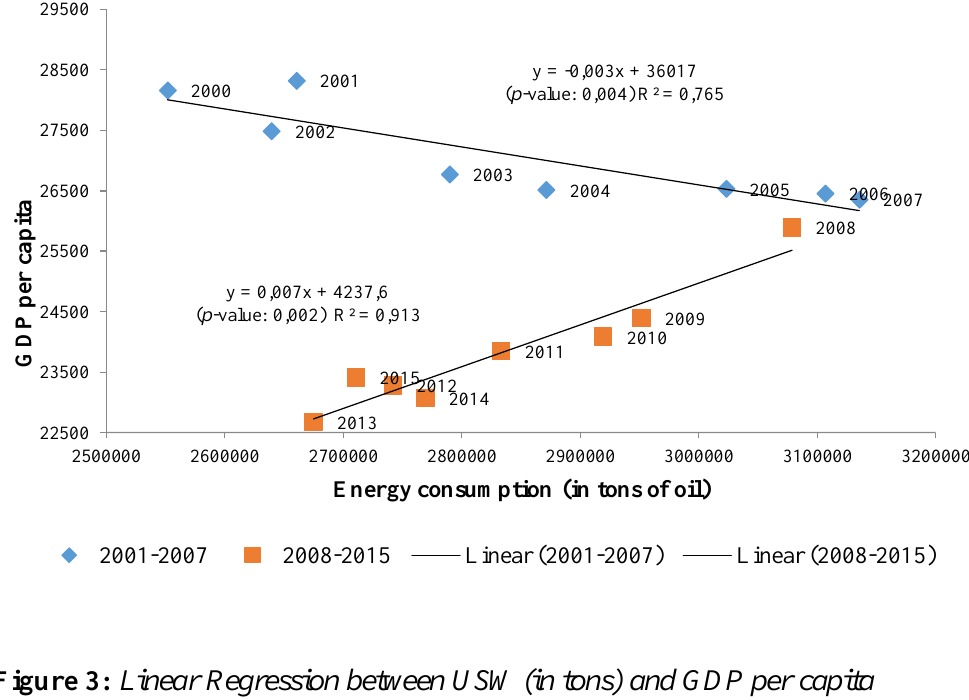
Figure 2: Linear Regression between Energy Consumption (in equivalent tons of oil) and GDP per capita